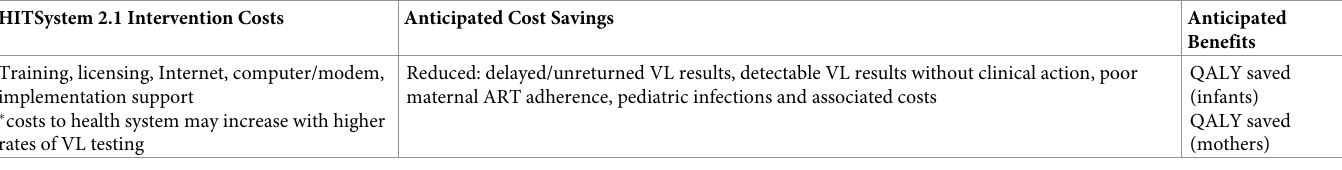
Table 4. Anticipated costs, savings and benefits for cost-effectiveness